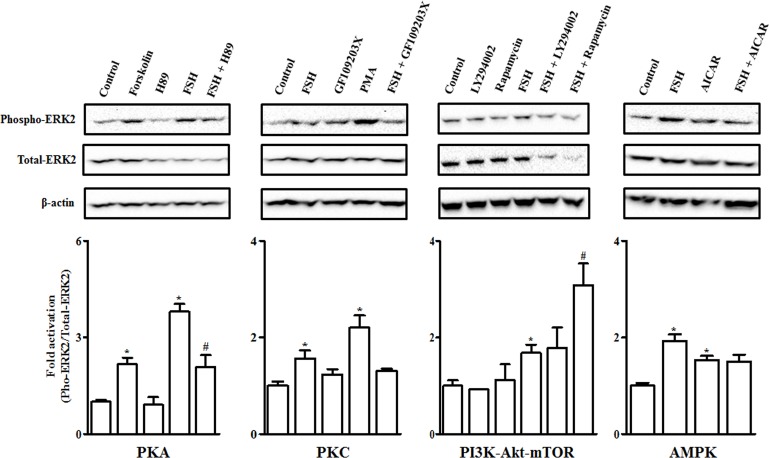
Effects of manipulation of several intracellular signaling pathways on basal and FSH-induced ERK2 phosphorylation in cultured granulosa cells of prehierarchical (6–8 mm) follicles.Top panel: Representative western blot analysis of phosphorylated and total ERK2 in granulosa cells treated without or with 10 ng/ml FSH in combination with PKA activator or inhibitor (10 μM Forskolin or 20 μM H89, respectively), or PKC activator or inhibitor (20 nM PMA or 10 μM GF109203X, respectively), or PI3K inhibitor (20 μM LY294002) or mTOR inhibitor (10 μM Rapamycin), or AMPK activator (1 mM AICAR). β-actin was used as loading control. Bottom panel: Quantitative analysis of relative protein abundance of phosphorylated ERK2 by densitometry using Image Lab software (Version 4.1, Bio-Rad laboratories). Relative protein abundance was normalized to total ERK2. Data are expressed as fold differences ± SEM of three independent experiments using tissues from different hens and are compared to control cells. *, P < 0.05 compared to control cells; #, P < 0.05 compared to cells only stimulated by 10 ng/ml FSH.